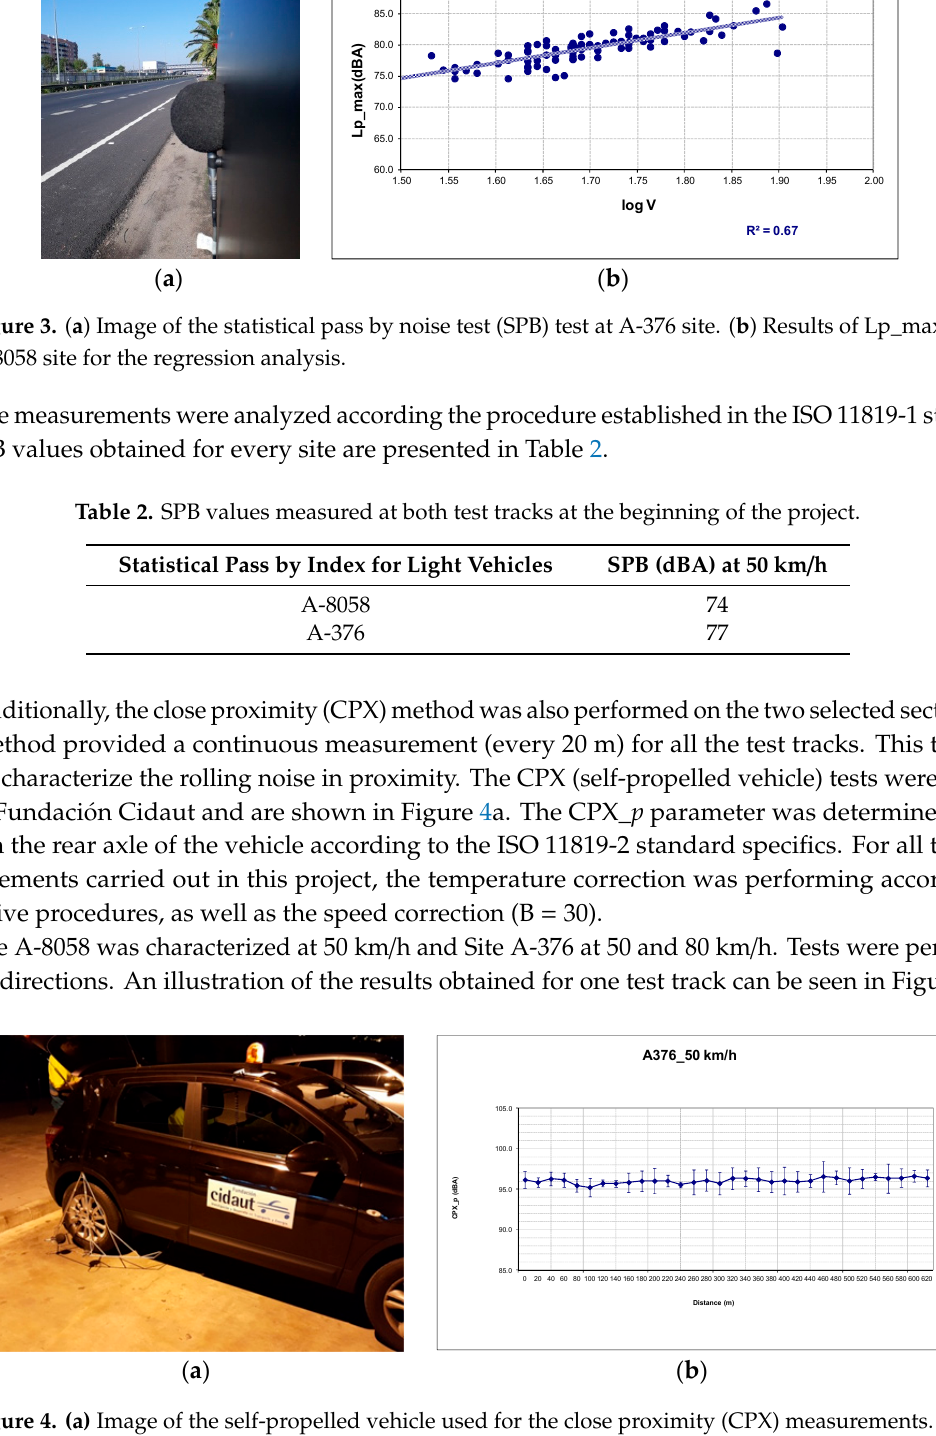
Figure 4. (a) Image of the self-propelled vehicle used for the close proximity (CPX) measurements. ( b ) Results of CPX_p at the A-376 site at 50 km/h.